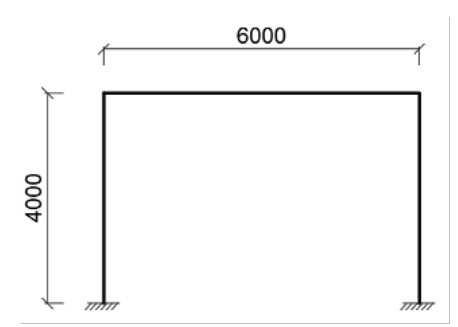
Figure 2. Designed concrete frame.